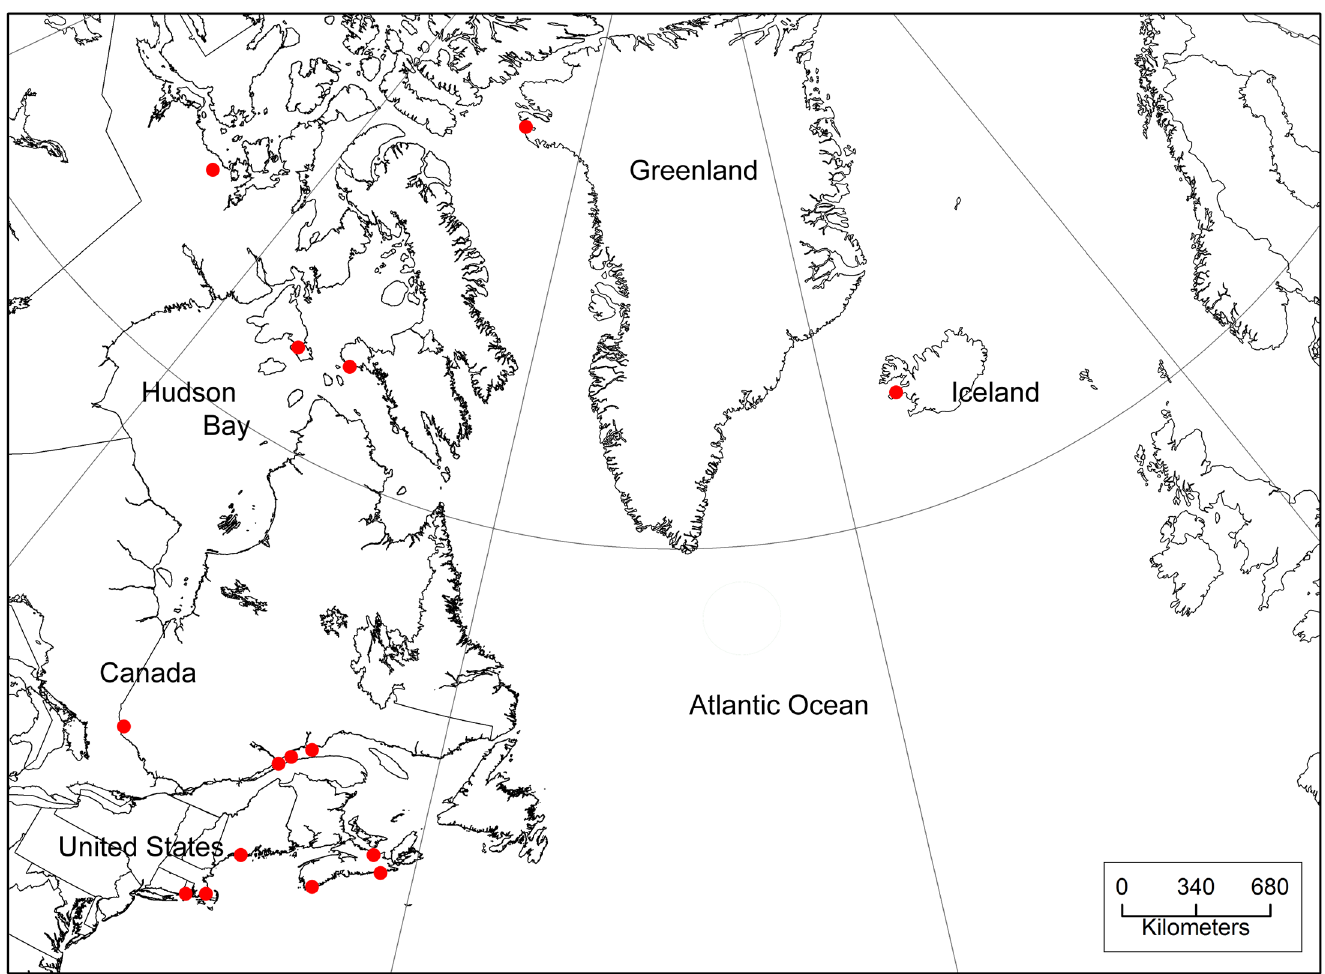
Fig 1. Sampling locations of sea ducks in the North Atlantic